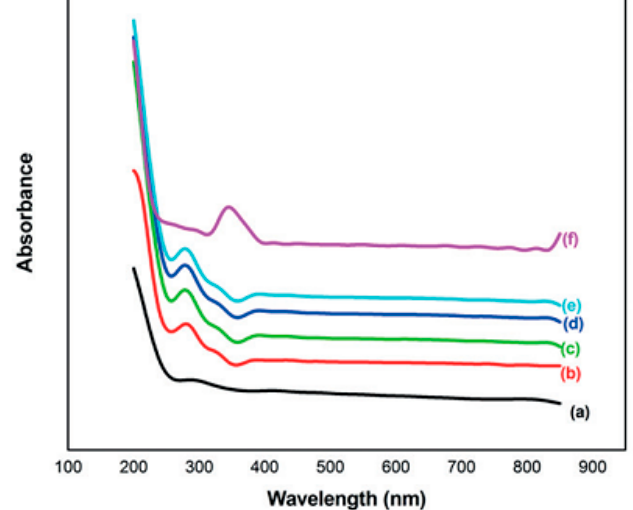
Figure 4. UV absorption spectra of PVA-LiPF6 films ( a ) 100:0; ( b ) 95:05; ( c ) 90:10; ( d ) 85:15; ( e ) 80:20 [76].